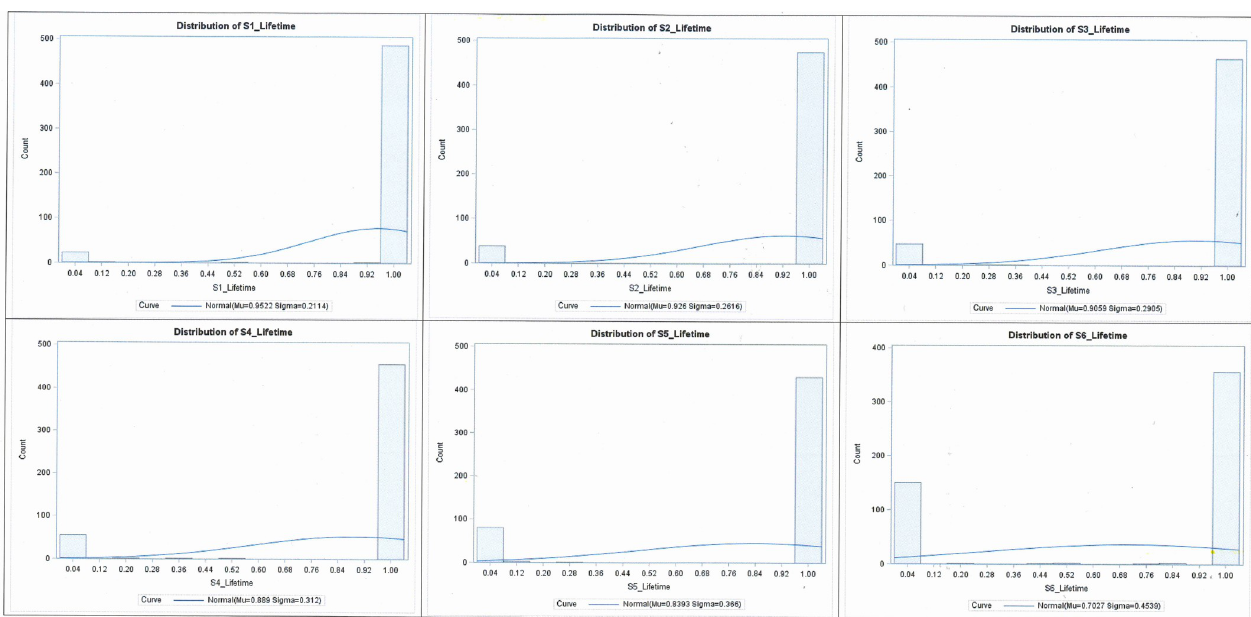
Fig 3. Standard gamble utility score distributions at the lifetime duration late stage cervical cancer. Legend: S1: Screened; cytology normal; S2: HPV positive with cytology normal; S3: Low grade cytology; S4: High grade cytology; S5: Early stage cervical cancer and S6: Late stage cervical cancer.